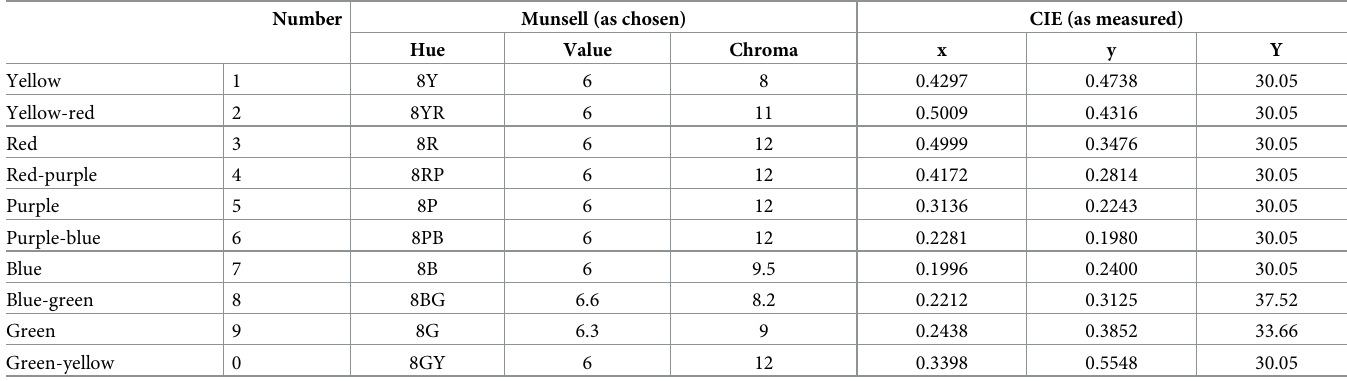
Table 1. Details of the colors used in the experiment.